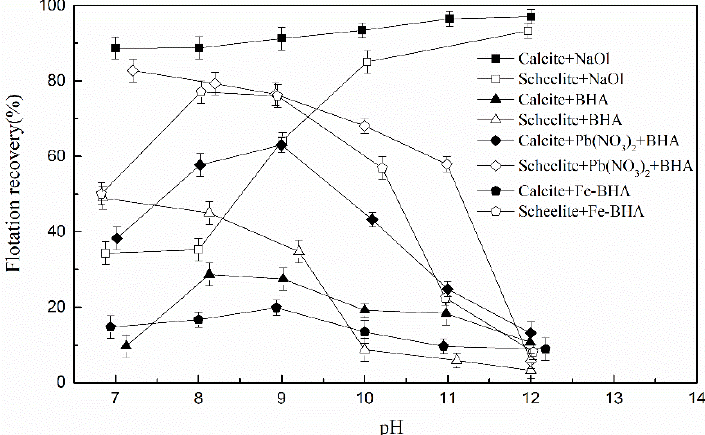
Figure 2. The flotation results of scheelite and calcite single mineral samples by NaOl (80 mg/L), BHA (160 mg/L), Pb(NO 3 ) 2 +BHA (Pb 2+ -—1 × 10 − 4 mol/L; BHA—160 mg/L), and Fe-BHA (Fe 3+ —1 × mg/L), Pb(NO 3 ) 2 +BHA (Pb 2+ —-1 × 10 − 4 mol/L; BHA—160 mg/L), and Fe-BHA (Fe 3+ —1 × 10 − 4 mol/L; 10 − 4 mol/L; BHA—160 mg/L) as a function of pH values. BHA—160 mg/L) as a function of pH